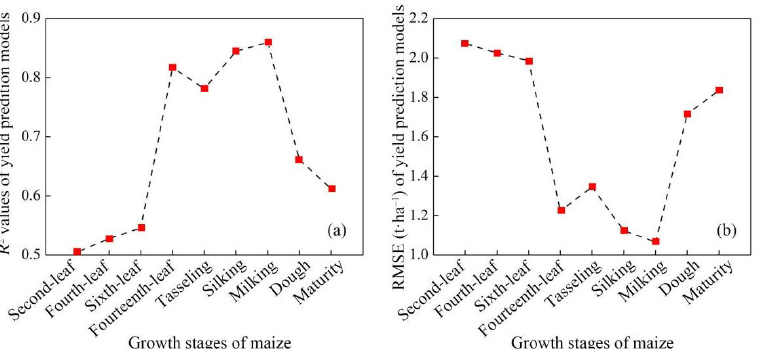
Figure 5. Yield prediction accuracy using different mono-temporal UAV data: ( a ) R 2 and ( b ) RMSE (t·ha − 1 ) values.